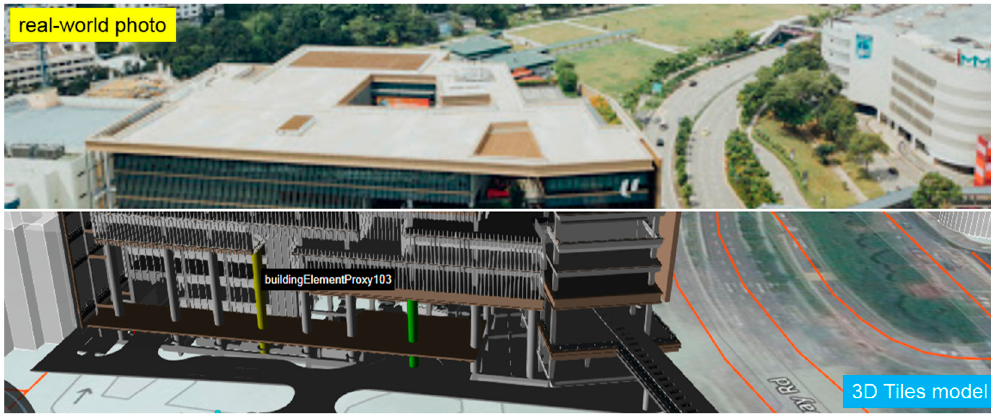
Figure 5. The converted 3D Tile model blends with its real-world photo from the same viewpoint.